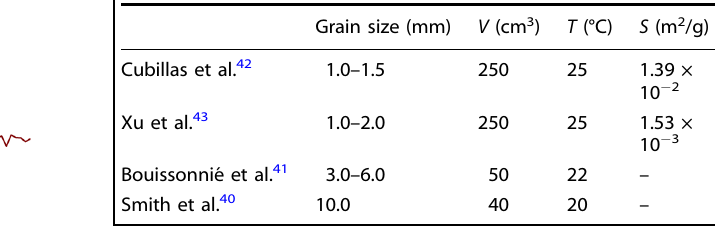
Table 4. General experimental conditions ( V : reactor volume, T : fl uid temperature, S : speci fi c surface area).